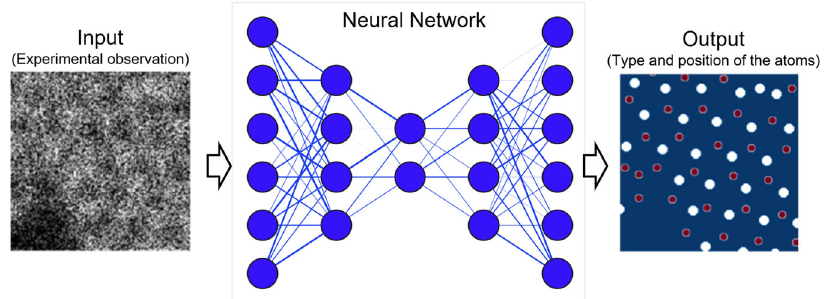
Fig. 1 Deep neural network for analyzing atomically resolved data by performing a semantic image segmentation 49,50 on the atomic level. The network accomplishes two goals: (i) it removes noise and (ii) it separates different atomic species into different classes on the level of individual image pixels. The input image is the scanning transmission electron microscopy image of disordered atomic lattice of 2D boron nitride; the output is the atomic coordinates.